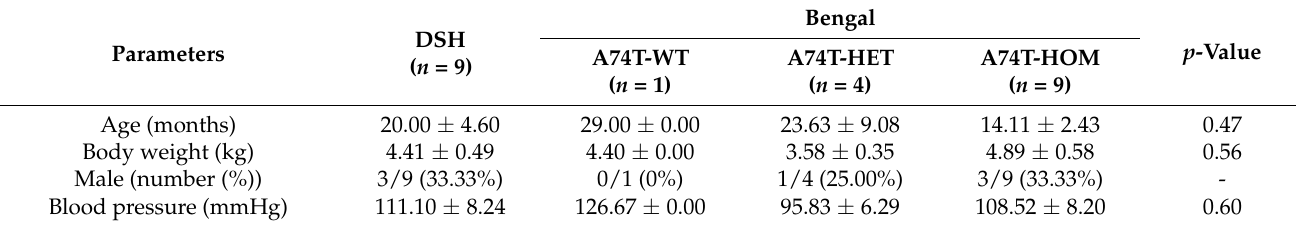
Table 1. Clinical characteristics of the study animals.